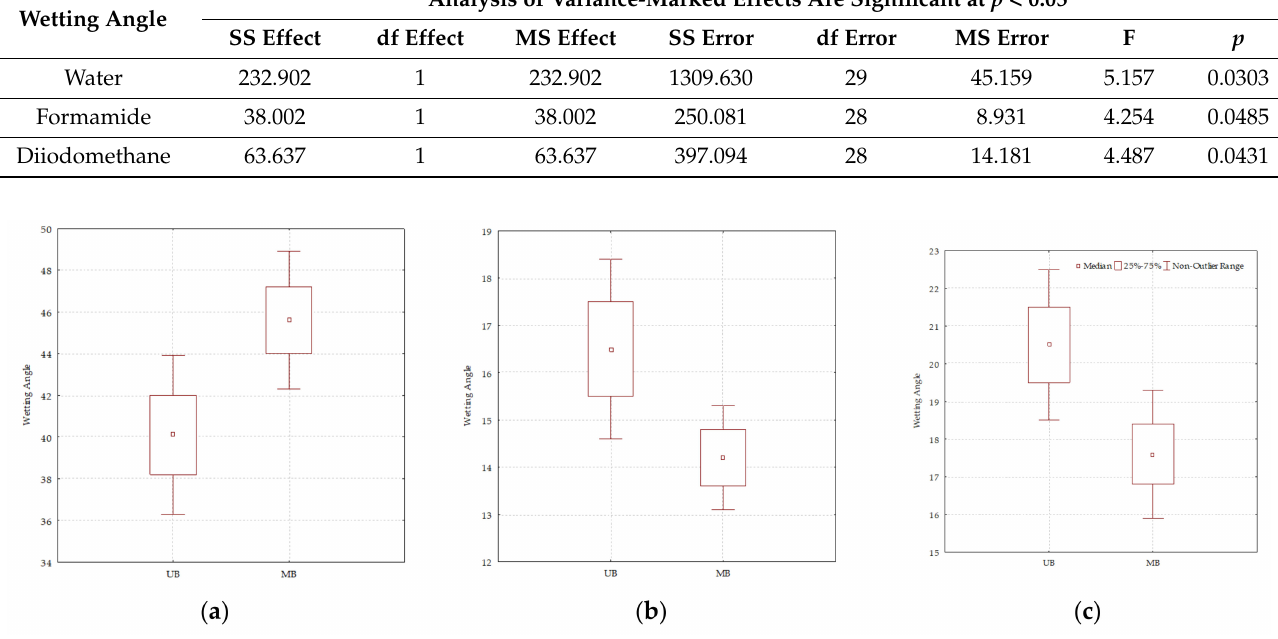
Figure 6. Statistical analyses of measured wetting angles; ( a ) water; ( b ) formamide; ( c ) diiodomethane. UB–unmodified beech wood, MB–modified beech wood.